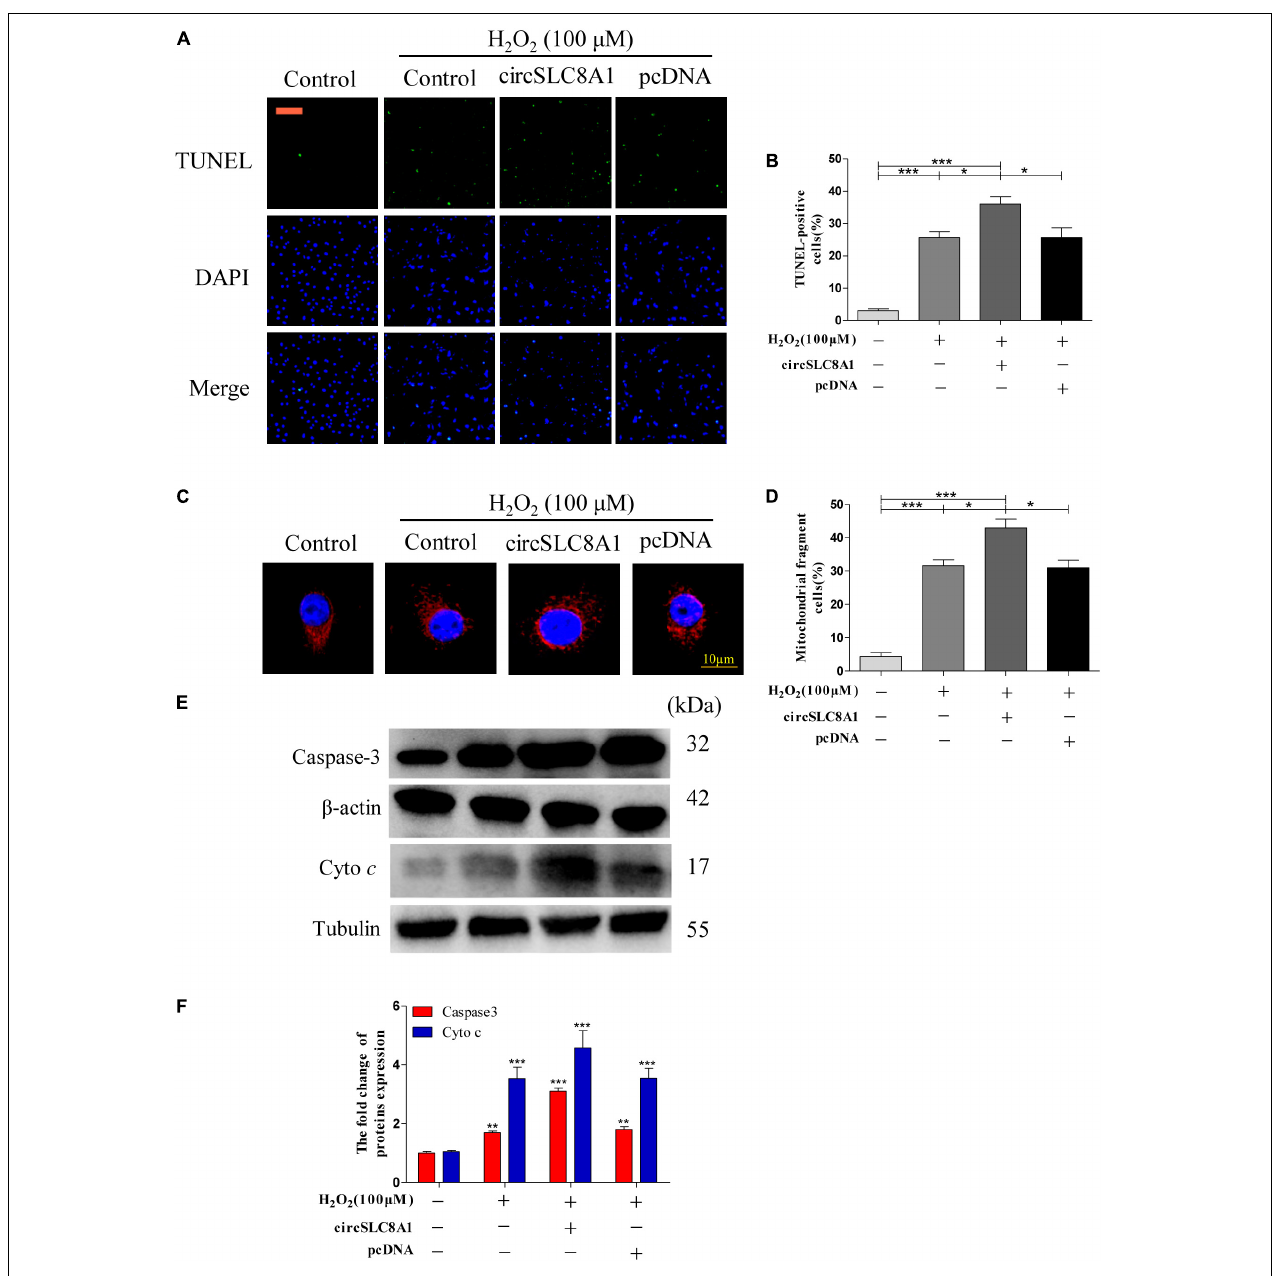
FIGURE 9 | Overexpression of circSLC8A1 sensitized myocardial cell to apoptosis under oxidative stress. (A) AC16 cells were exposed to 100 µ M H 2 O 2 for another 12 h after transfected with circSLC8A1-cDNA for 24 h, and apoptosis was stained with TUNEL. (B) The percentage of cells underwent TUNEL positive cell. (C) AC16 cells were exposed to 100 µ M H 2 O 2 for another 12 h after the overexpression of circSLC8A1, and the mitochondria was stained with MitoTracker Red. (D) The percentage of cells underwent mitochondrial fission. (E) The expression levels of apoptotic-related proteins were detected by western blotting. (F) The data analysis of blot densitometry. All of the data were expressed as the mean ± SEM of three independent experiments. * P < 0.05, ** P < 0.01, *** P < 0.001.